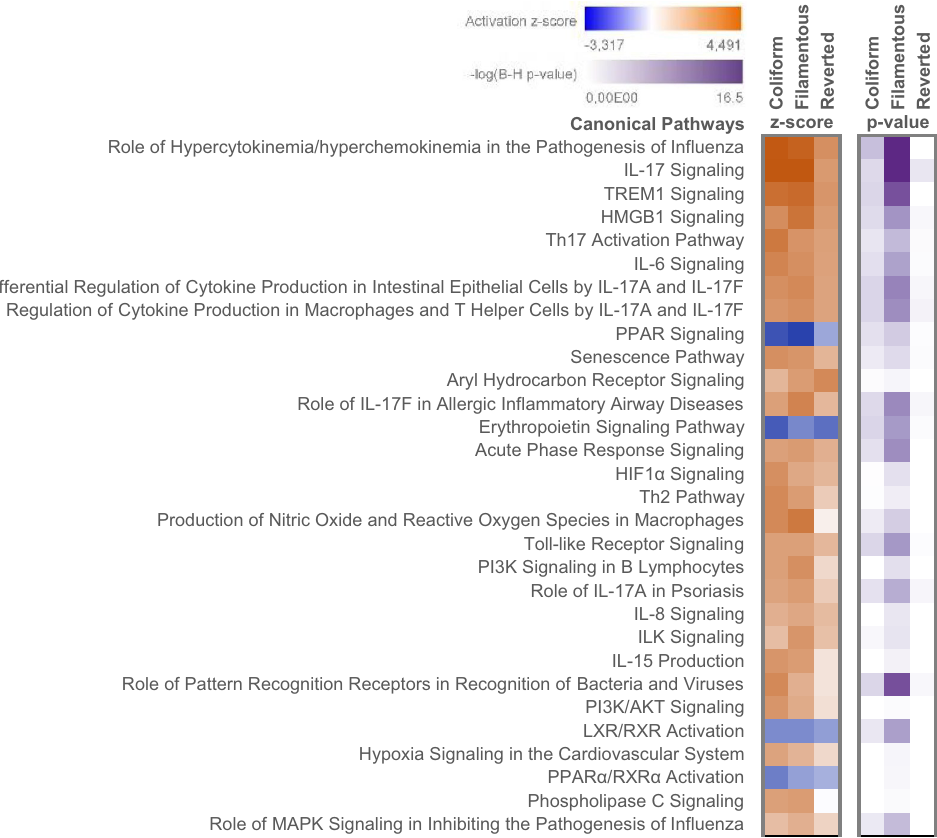
Figure 5. A comparative analysis of canonical pathways showing enrichment of altered gene entities in functional pathways in HBEP cells stimulated with Coliform, Filamentous and Reverted bacteria compared to unstimulated control cells. The top 30 activated pathways are shown, and data are presented as activation z-score and − log B-H corrected p -value.